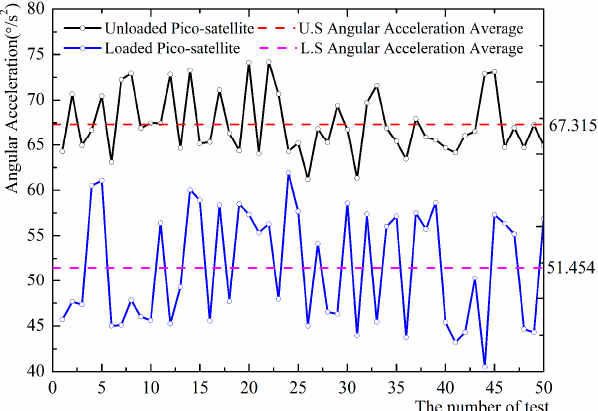
Figure 13. Angular acceleration in different states at horizontal position- β .